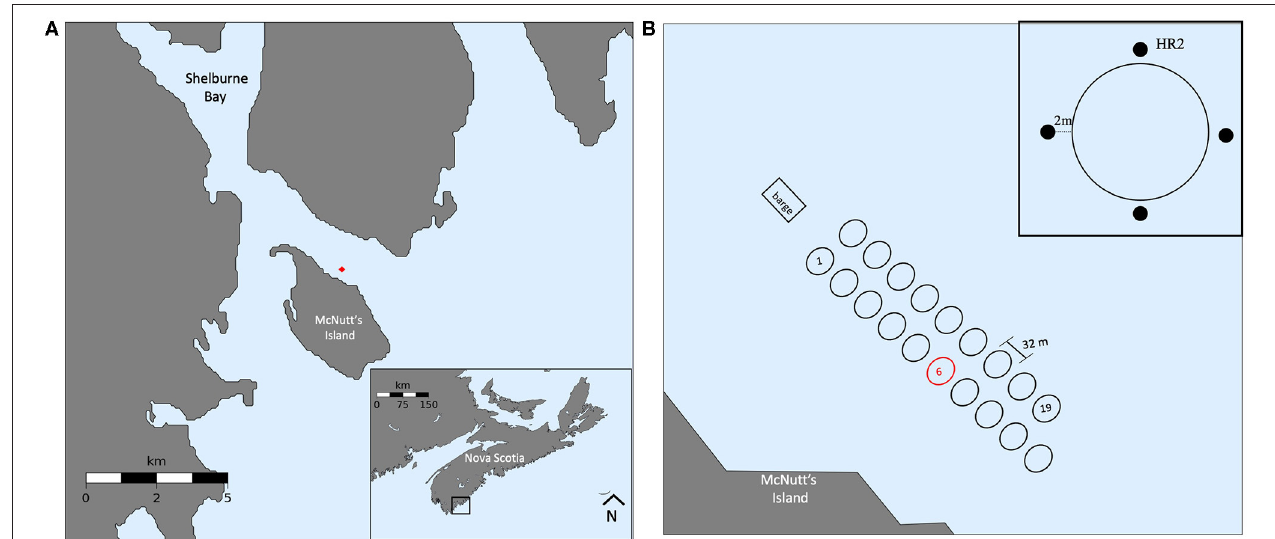
FIGURE 1 | Study site map. (A) Regional map of Shelburne Bay with site location marked in red, and inset showing location in Nova Scotia, Canada. (B) Zoomed site map with farm orientation and net pen schematic; study net pen highlighted in red, inset showing schematic of acoustic receivers.